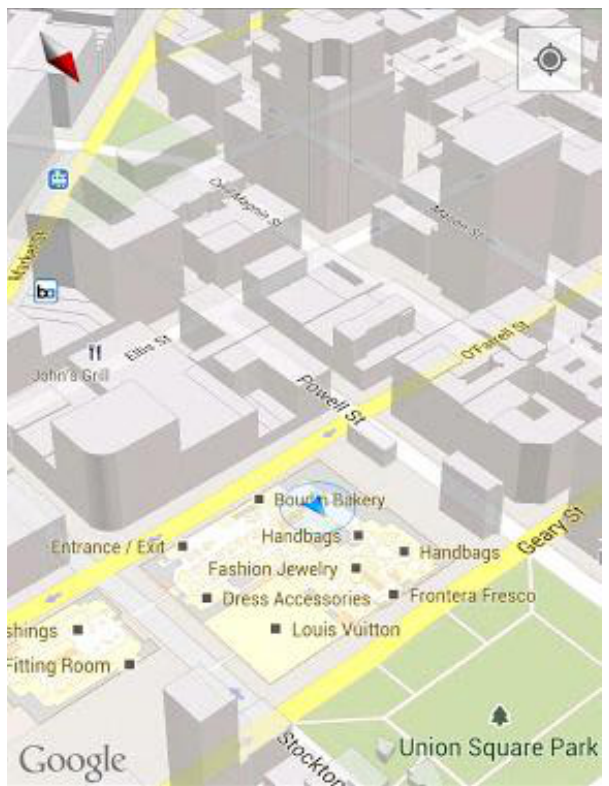
Figure 2. 3D tilt, zoom, and rotation enabled mobile map displayed in Google Maps 6 for Android devices